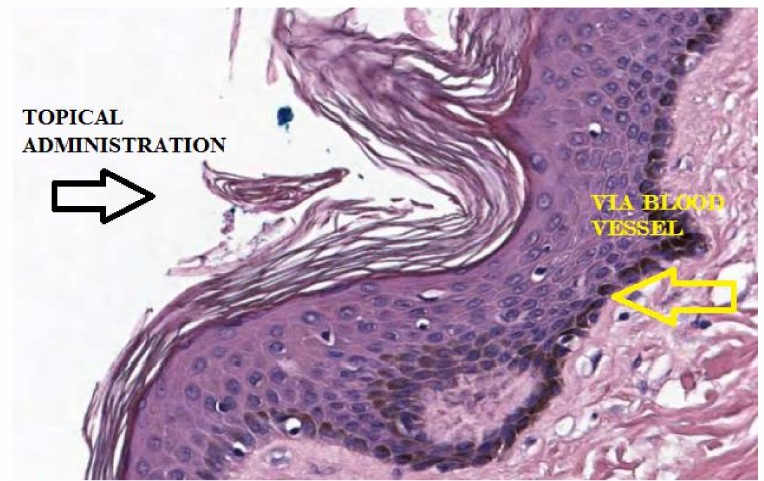
Figure 3. Enlarged representation of the skin. In pink, the layer of the dermis, supplied by blood vessels that allow the transport of nutrients towards the epidermis in dark